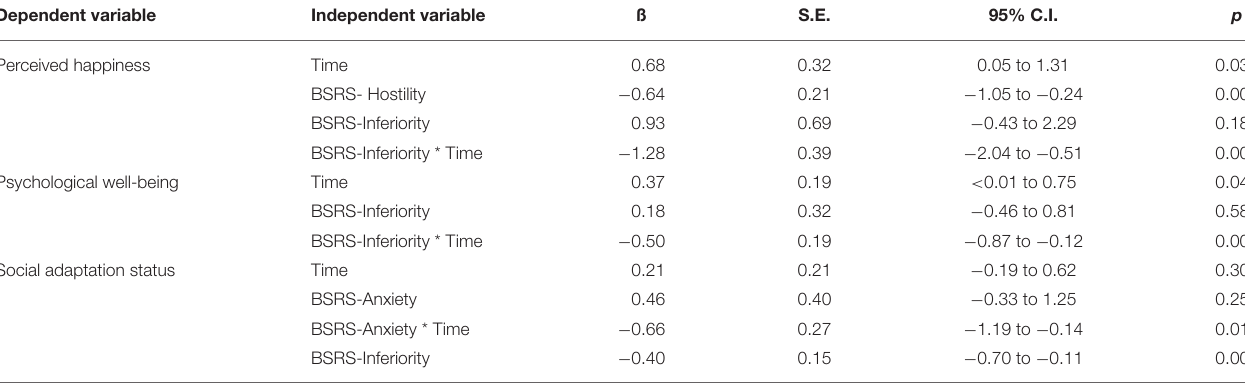
TABLE 3 | Parsimonious generalized equation estimation model of the factors associated with the level of happiness of healthcare workers over time.